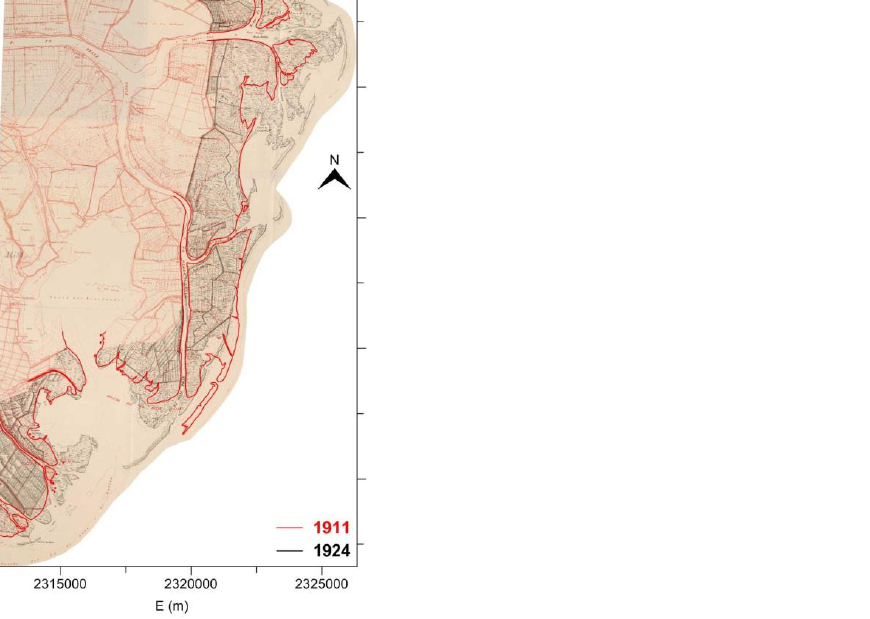
Figure 5. Photo-plan mosaic of the 1949 aerial photogrammetric survey: available images cover most of the PRD area in Veneto region and a portion of the Emilia Romagna region; visibility on aerial photographs increases, although not yet optimal.